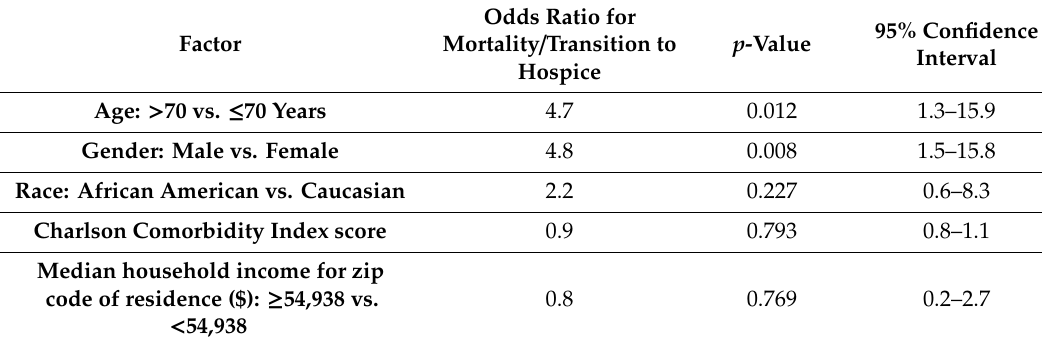
Table 3. Multivariate analysis: factors associated with primary outcome in hospitalized patients. Odds Ratio for 95% Confidence p -Value Factor Mortality / Transition to Interval Hospice Age: > 70 vs. ≤ 70 Years 4.7 0.012 Gender: Male vs. Female 4.8 0.008 1.5–15.8 Race: African American vs. Caucasian